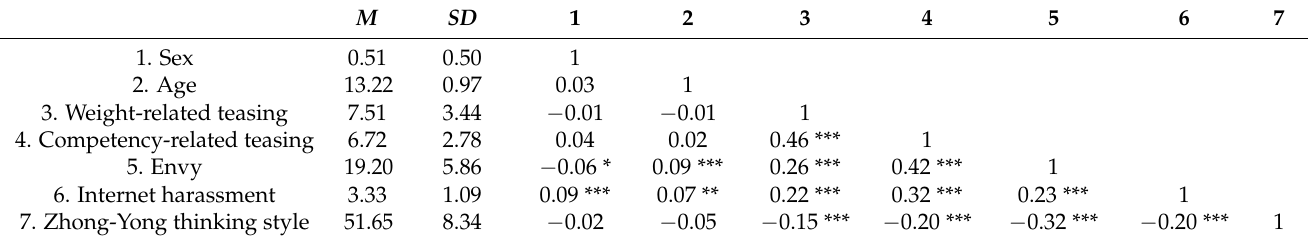
Table 1. Descriptive statistics and correlations among